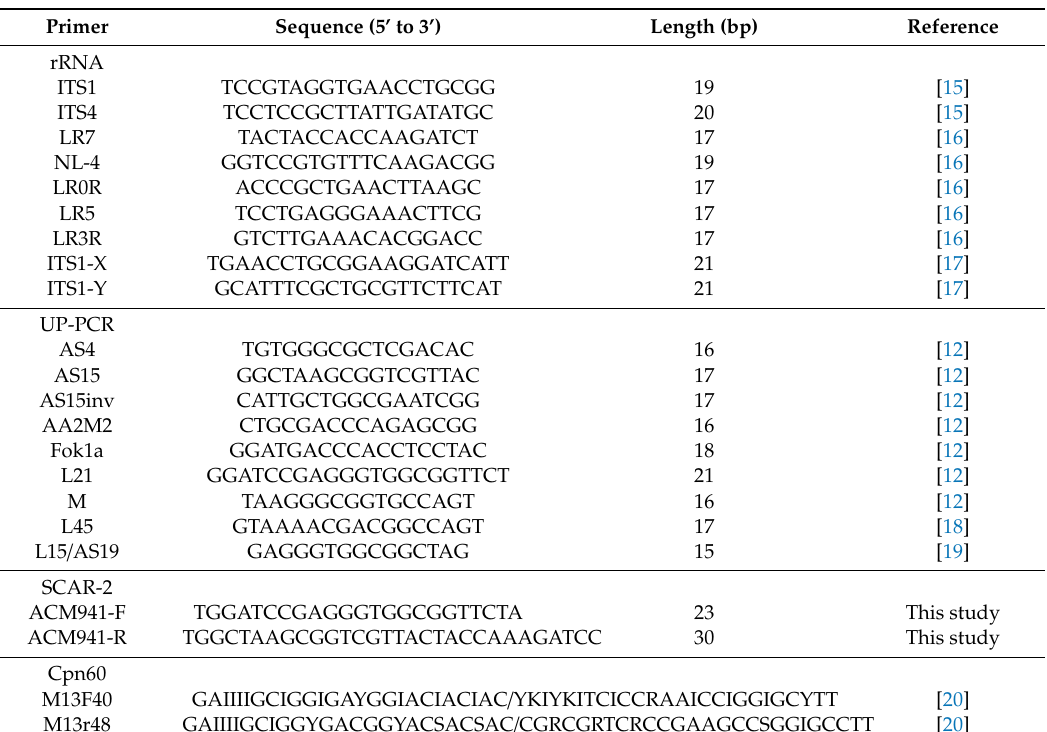
Table 2. Primers used in this